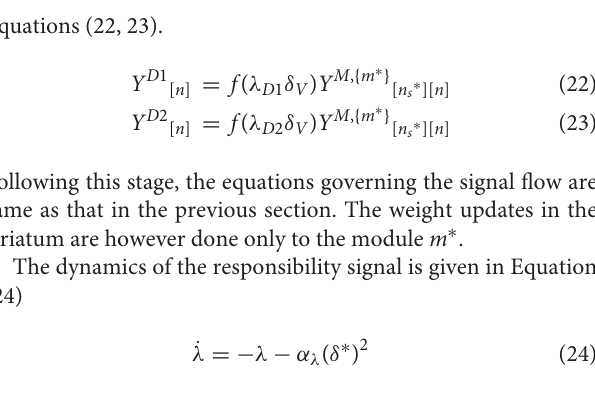
Frontiers in Neural Circuits |